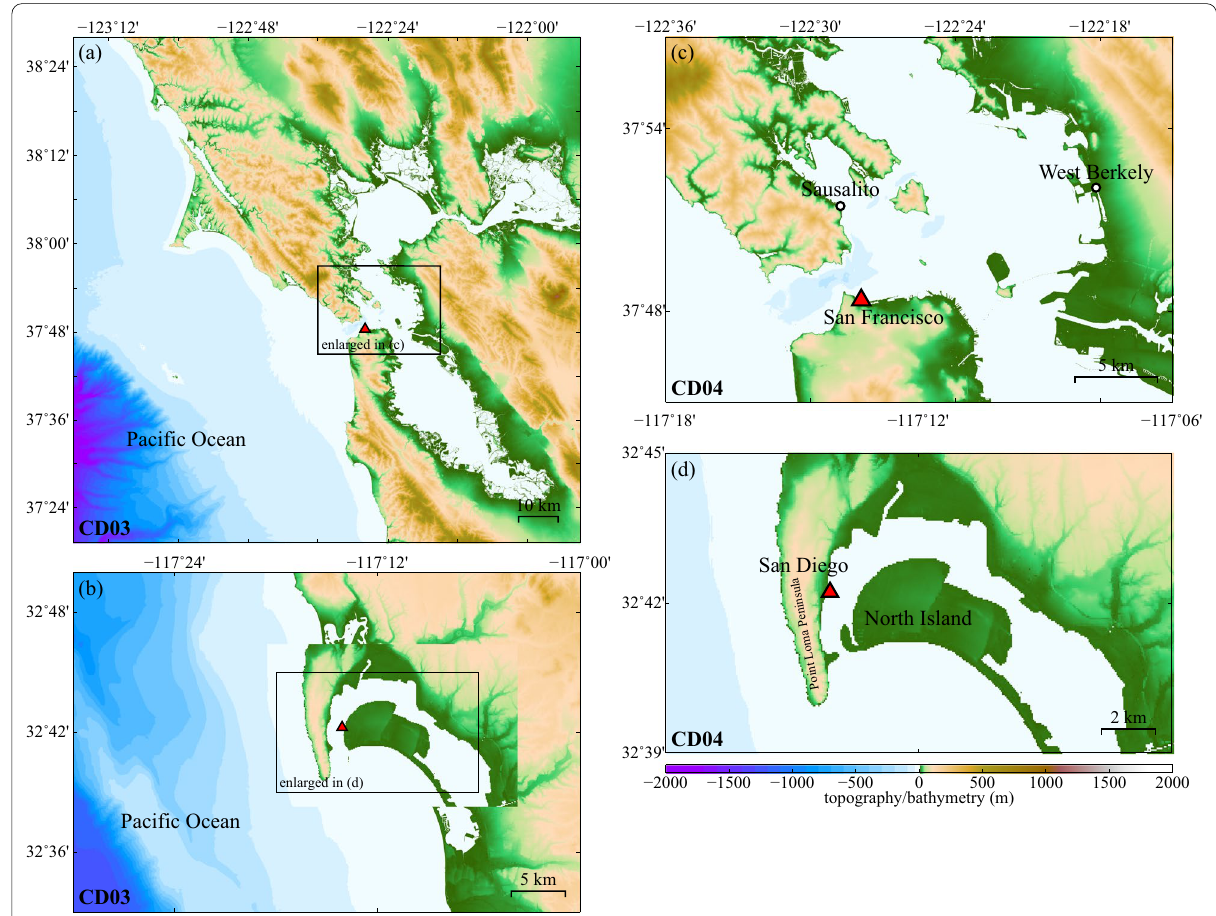
Fig. 2 Topography and bathymetry around the a , c San Francisco and b , d San Diego tide gauge stations. CD03 and CD04 are the computational domains of 6 and 2 s in grid intervals, respectively. These data were manually reproduced based on old maps, and coastal structures were manually removed by referring to old maps (OldMapsOnline; https:// www. oldma psonl ine. org/). Red triangles show the locations of the tide gauge stations in 1854